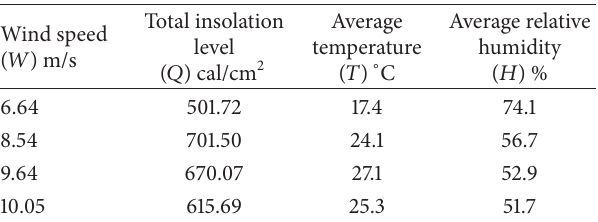
Table 2: The monthly average meteorological parameters from May, June, July, and August 2012. Wind